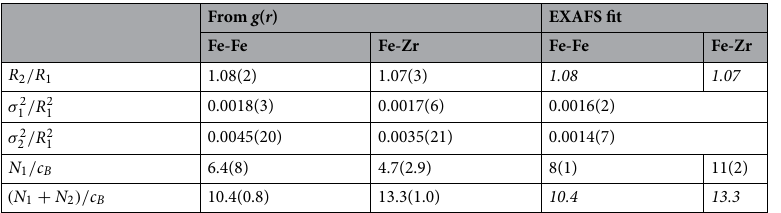
Table 5. Scaled parameters used in the EXAFS fits that are common for all compositions. The actual 2 2 N 1 , and N 2 ) are different for all concentrations since parameters that are used in the EXAFS paths ( R 2 , σ 1 . σ 2 , A − B c B ). The errorbars are estimated from the compositional they are scaled by either R 1 or the B atom content ( variations. The parameter values are obtained from the fitting to the experimental EXAFS data except those written in italic that were fixed to the value obtained in the Gaussian fitting of the simulated partial radial distribution functions, g ( r ).